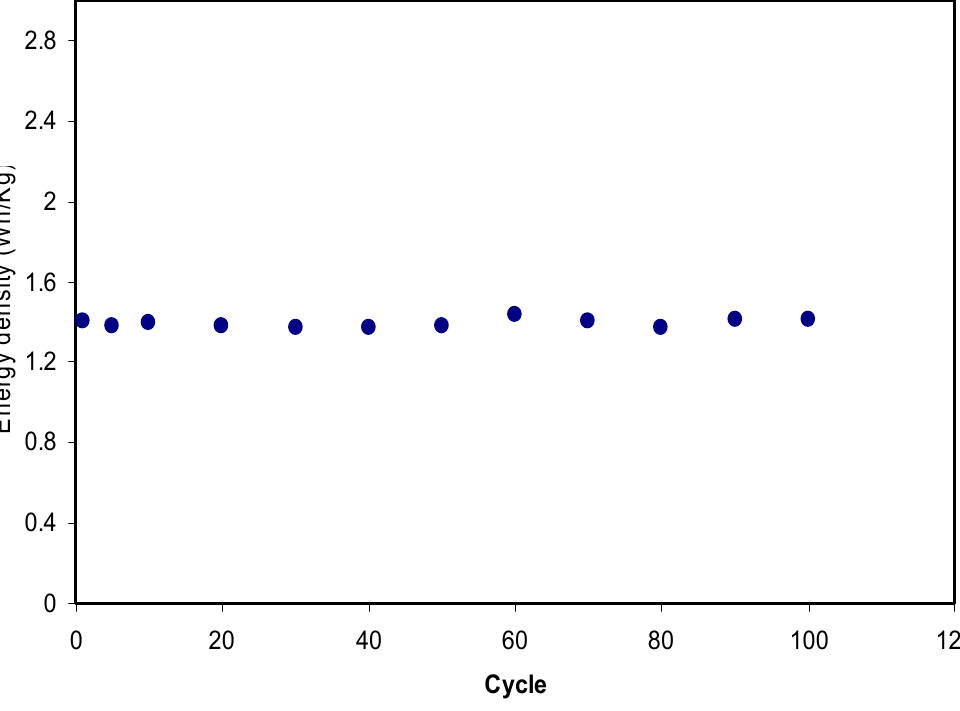
Figure 14. Energy density of the fabricated EDLC for 100 cycles.